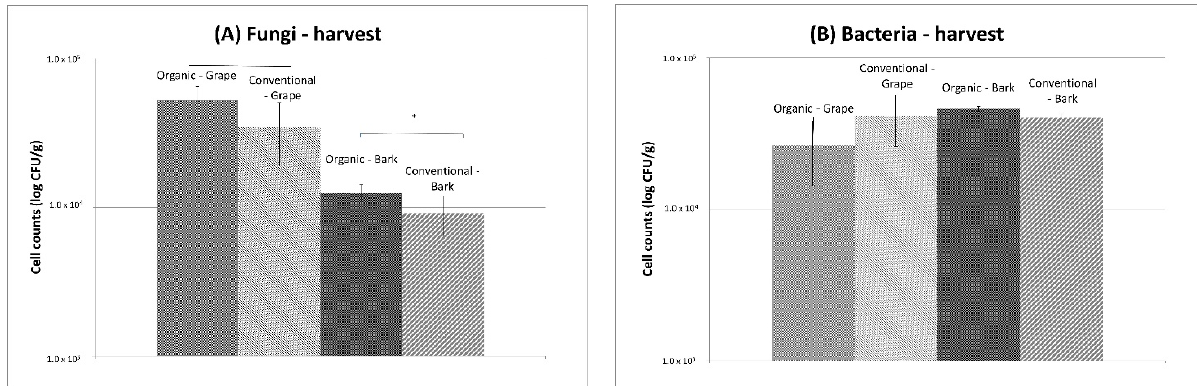
Figure 2. Yeast and bacteria population in grape and bark samples a few days before harvest. ( A ) Yeast/fungal populations determined on WL agar; ( B ) Bacterial populations determined by plate counts on PCA agar. Vertical bars show standard deviation (each condition represents four biological samples thta were diluted and plated in triplicate). * shows significant difference between groups ( p < 0.05).